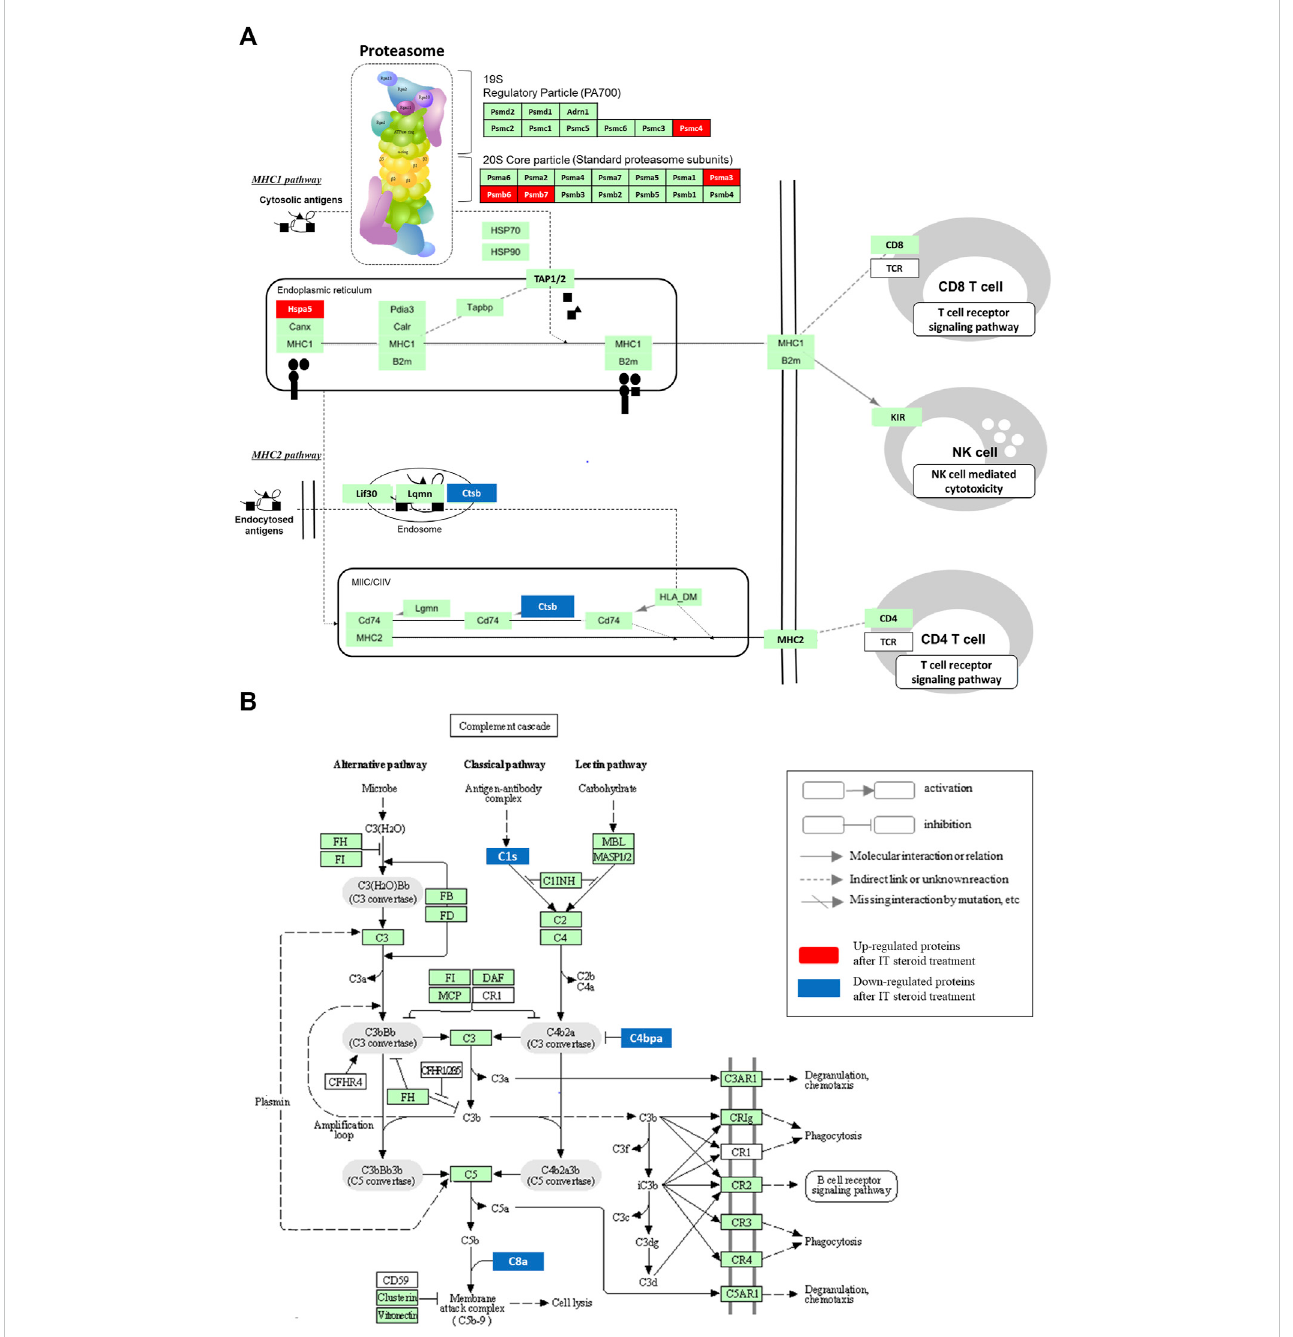
KEGGpathwaydescription of DEPsembedded inantigen processing with proteasomecomplex pathway (A) , and complementand coagulation cascade (B) . Among the KEGG pathway fi ltered with FDR value lower than 0.05, the immune related antigen processing (map04612) coupled with proteasome (map03050) pathway, and complement and coagulation cascade (map04610) were resulted with identi fi ed